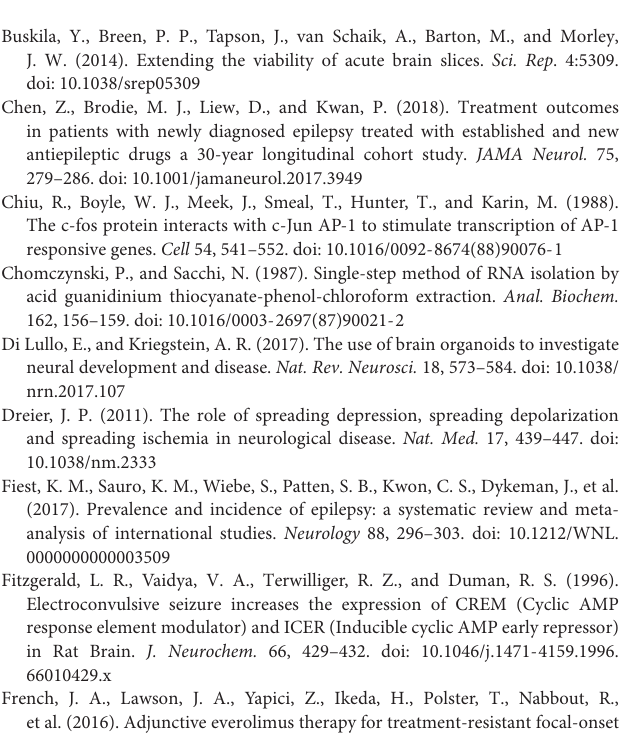
regions processed: hippocampus, entorhinal cortex and temporal cortex. (B) Cq of five candidate reference genes in all conditions across the three regions investigated (hippocampus, H , entorhinal cortex, EC, and temporal cortex, TC). The box chart indicates the first and the third interquartile range. The vertical line across the box indicates the median, while the lower and upper dashes show the minimum and maximum values. (C) Expression stability values ( M ) of the five candidate reference genes evaluated by NormFinder. A lower stability value indicates a more stable expression. Reep5 in hippocampus and Tbp in temporal cortex showed a standard deviation > 0.25, so they were excluded from the determination of the stability value. Supplementary Figure 3 | Gene expression of c-Fos in basal rat slices. Duration of brain slice procedure (from decapitation to cell lysis in TRIzol) positively correlated with basal c-Fos mRNA levels. Relative to the reference gene Ywhaz, c-Fos expression in basal slices was highest in temporal cortex (TC) followed by entorhinal cortex (EC) and hippocampus (H) in decreasing order. Supplementary Figure 4 | Gene expression of Icer and mTor in rat slices. Fold induction of Icer (A–C) and mTor (D–F) relative to basal gene expression in hippocampus, entorhinal, and temporal cortex, respectively. All investigated conditions are represented: control slices (control) and 4-AP treated slices (4-AP) with experimental duration of 1, 2, 3, or 4 h. For relative quantification in RT-qPCR, Ywhaz was used as reference gene. Scatter plots show means of individual rats ( n = 20) since tissue was pooled before RT-qPCR, superimposed graphs represent median ± interquartile range ( ∗ p < 0.05, ∗∗ p < 0.01, ∗∗∗ p < 0.001). Supplementary Figure 5 | Reference gene identification for human slices. (A) Mean quantification value ( Cq ) and standard deviation of three reference genes determined in two independent samples for each condition considered for human samples (basal, control, onset site, rest of slice; n = 8). (B) Cq of three candidate reference genes in all conditions. The box chart indicates the first and the third interquartile range. The vertical line across the box indicates the median, while the lower and upper dashes show the minimum and maximum values. (C) Expression stability values ( M ) of the three candidate reference genes evaluated by NormFinder. A lower stability value indicates a more stable